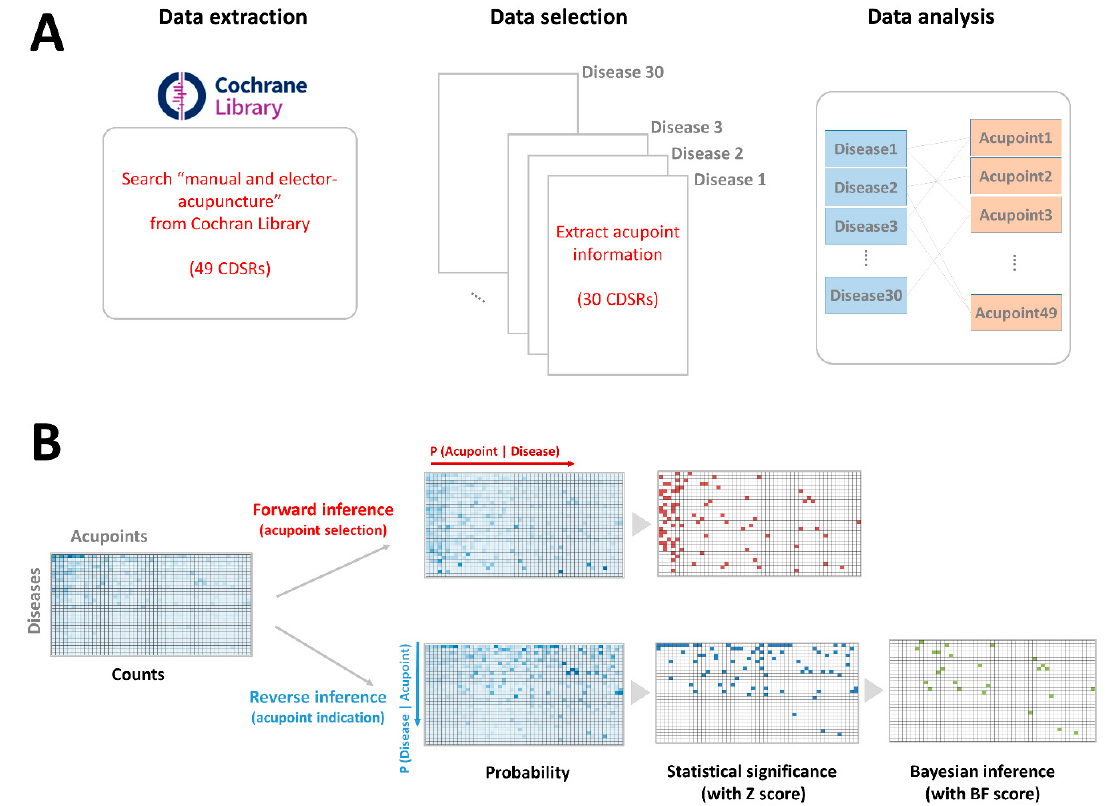
Figure 1. Data extraction and data analysis. ( A ): Data extraction procedures. The frequencies of the co-occurrences of the 49 acupoints and 30 diseases were extracted to explore the associations between diseases and acupoints. ( B ): Data analysis procedures. For forward inference, acupoints prescribed for each disease were quantified. For reverse inference, diseases for each acupoint were quantified. Probability values were Z-transformed to assess statistical significance for both forward and reverse inference (Z > 1.96). Bayes factor correction was applied to reverse inference to adjust for the odds of the prior probability of the disease. BF: Bayes